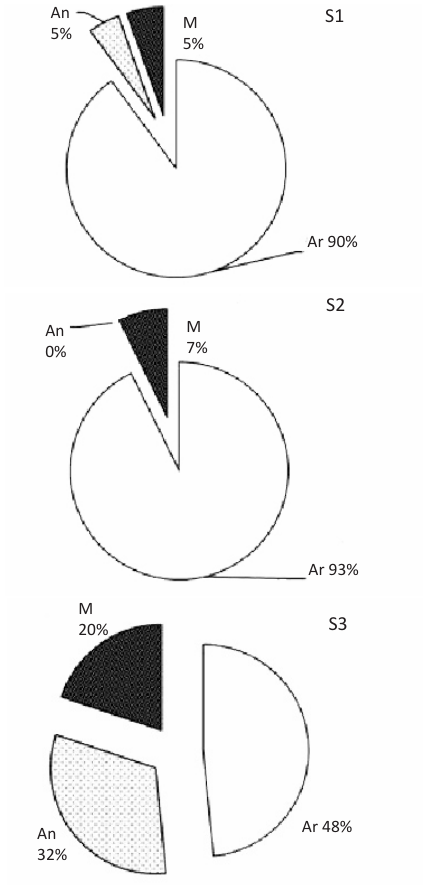
Figure 2. Percentage composition of higher taxonomic groups (An - Annelida; Ar - Arthropoda; M - Mollusca) at stations S1 to S3, in the Ken